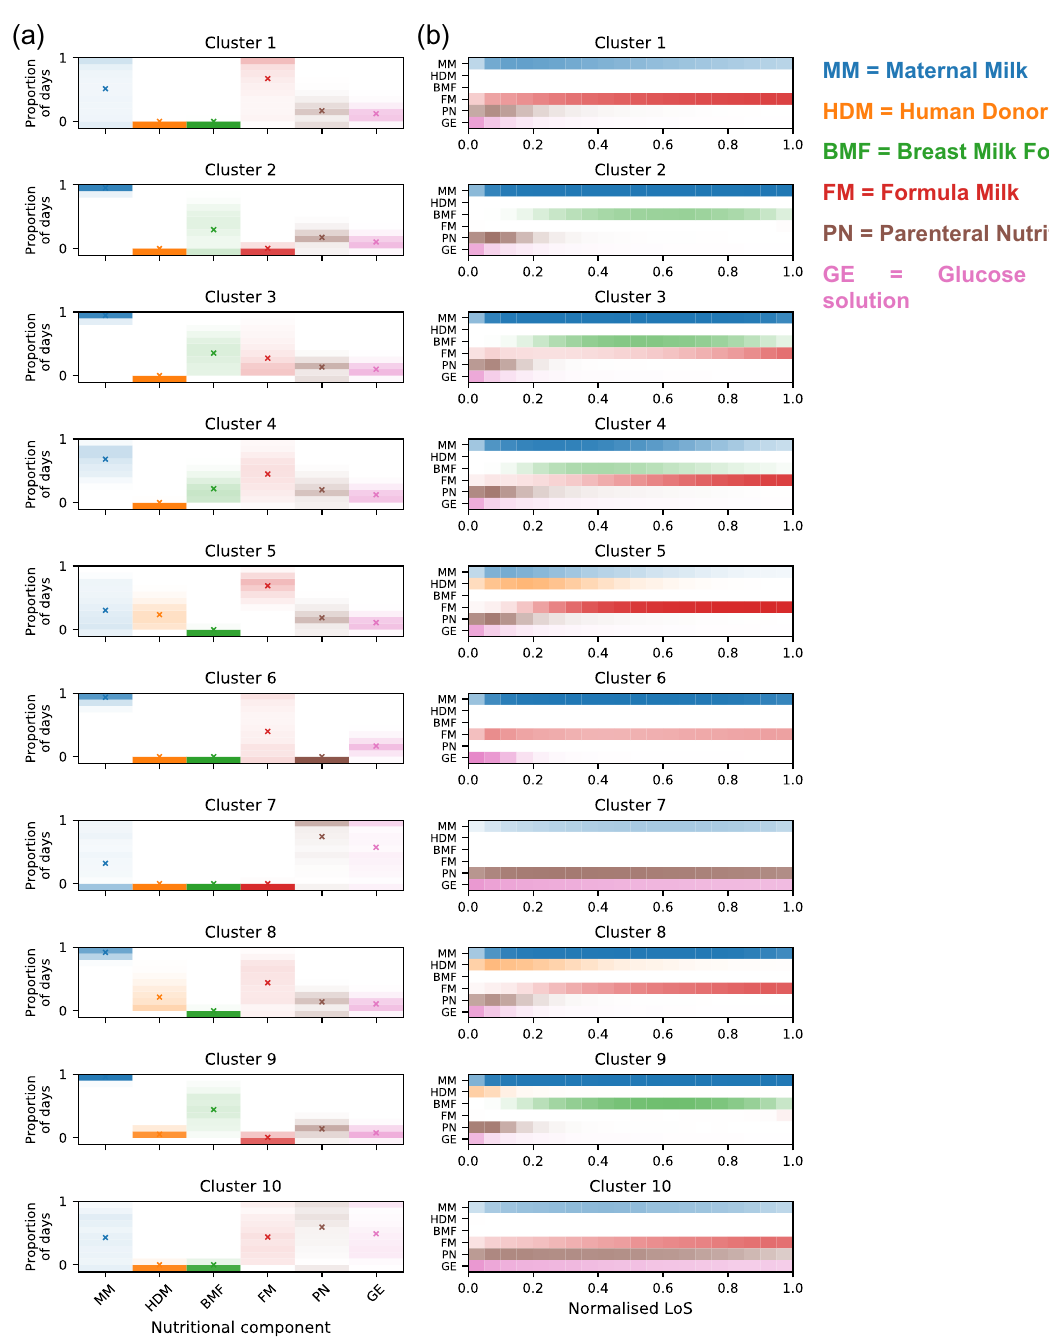
Figure 2. Composition of the 10 most common nutritional patterns ordered by size from largest to smallest. Nutritional patterns are encoded as the proportion of days over total time in care a nutritional component was given (0 to 1). ( a ) Histograms of proportion of infants receiving a nutritional component (one per column) over a given proportion of days. Shading = one-dimensional histograms (11 bins-width = 0.1-including 0). Colour intensity = density of infants fed with that proportion over time in care and is maximal if all infants fall into a single bin. Cross (“x”) = mean proportion of days averaged across all infants in the cluster. ( b ) Timeline of nutritional components administration over normalised LoS (20 equal bins), computed as average temporal sequences of nutritional events over time in care. Maximal bin value (and colour intensity) attained if all infants in the cluster received a particular nutritional component every day in that time